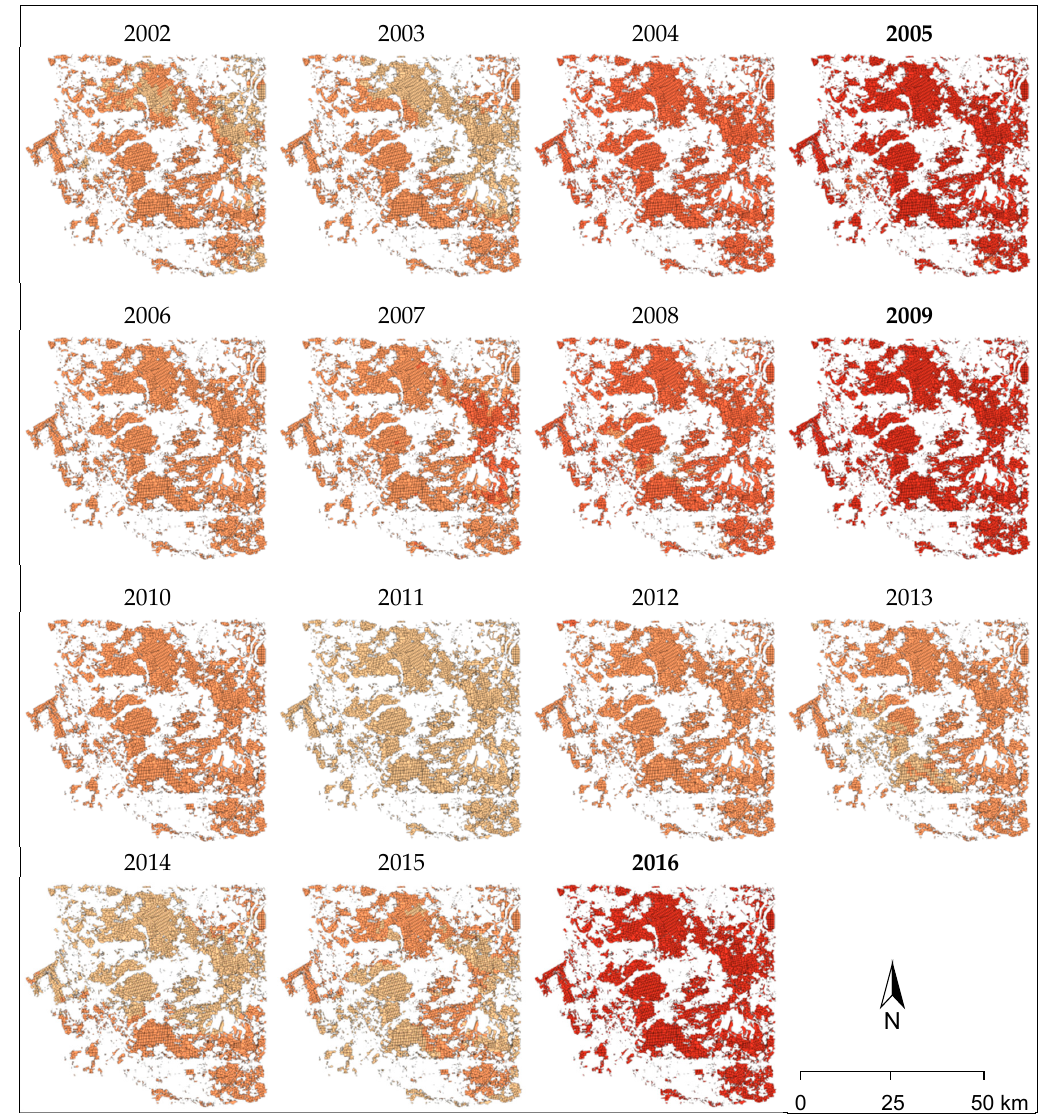
Figure 10. Years classified by the top four trigger variables. The coloring scales in five classes of equal width plotted as red shadings. Dark colors indicate favorable climatic conditions for D. pini mass outbreaks; observed outbreak years are printed in bold.